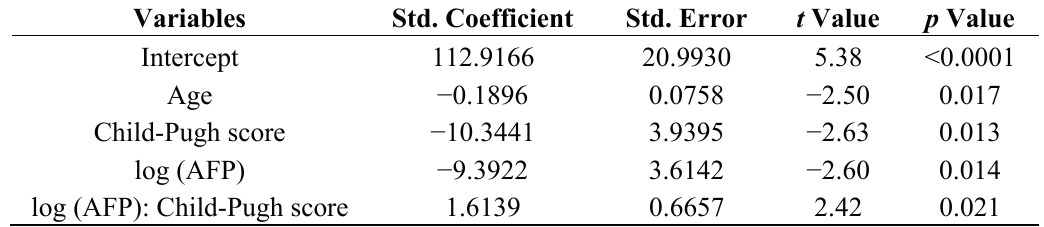
Table 5. Multiple linear regression analysis with L3 skeletal muscle index (SMI) and significantly explanatory valuables including each other’s